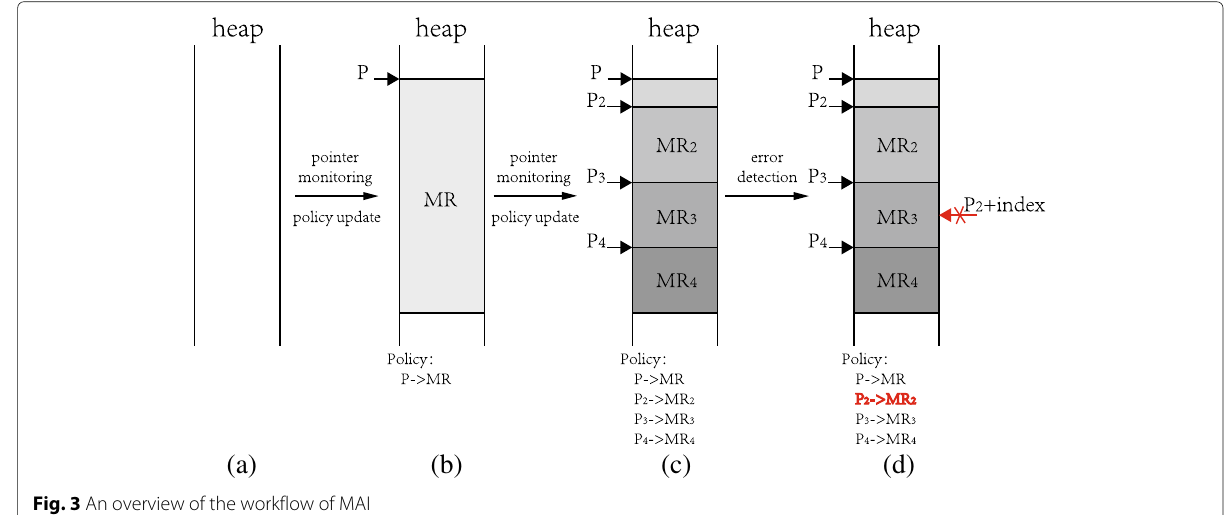
code to do fine-grained detection. These methods are still not feasible for detection of fine-grained memory access errors in binary